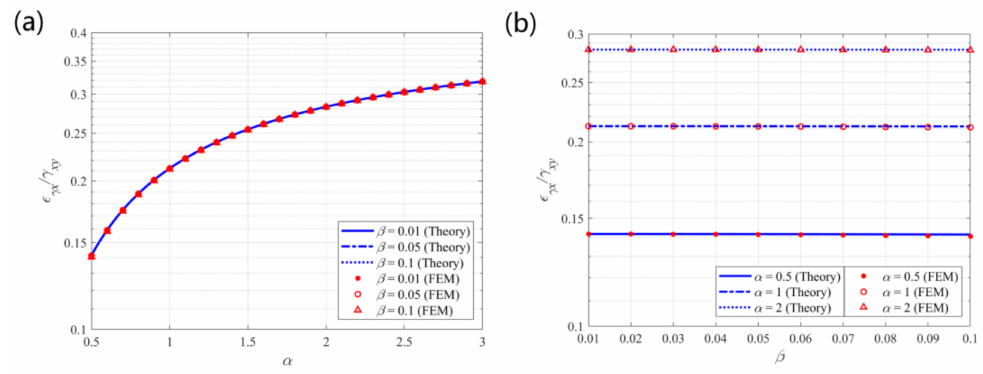
Figure 10. Theoretical predictions and finite element results for the coupling effect ε γ x / γ xy vs. ( a ) α and ( b ) β .